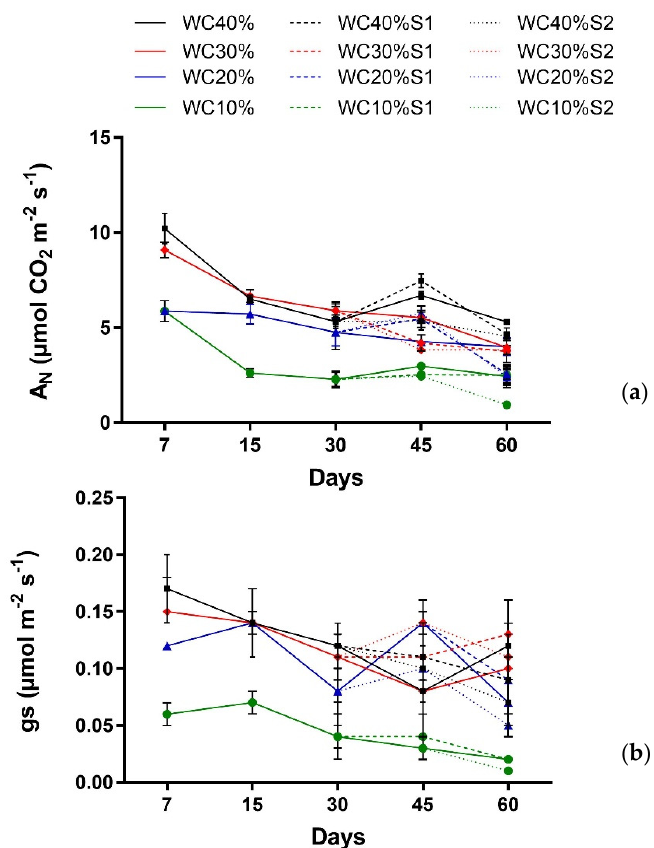
Figure 5. Trend of net photosynthesis (A N ) ( a ) and stomatal conductance (gs) ( b ) in Viburnum plants affected by drought (WC 40%: control; WC 30%: light drought stress; WC 20%: moderate drought stress; WC 10% severe drought stress) and saline aerosol treatment (S0: Distilled water, S1: 50% Synthetic seawater solution, S2: 100% Synthetic seawater solution). The plants were subjected of drought stress for four weeks; subsequently the plants were also treated with saline aerosol treatment. Data are means ± standard error ( n = 3). Three biological replicates were used for the measurements. Table 5. Summary of the main and interaction effects of days (T) and drought (D) in the first 30 days, and of days (T), drought (D), and saline aerosol (A) for the other 30 days on (A N ) and stomatal conductance (gs) of potted Viburnum. A N